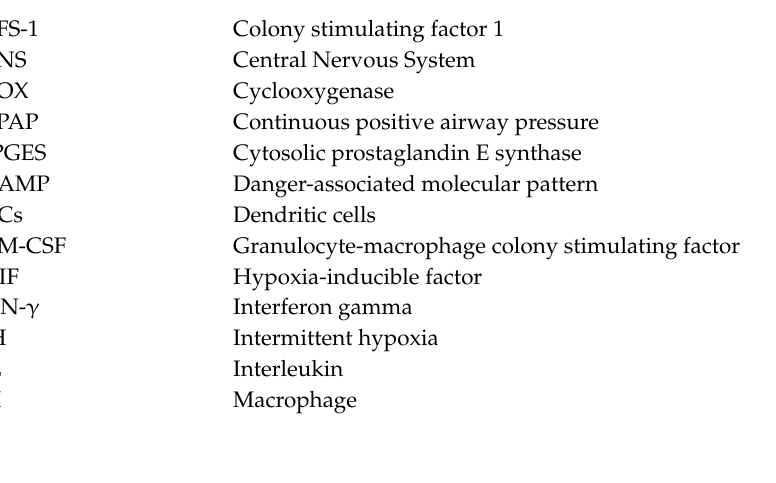
Table S1: Regulatory role of the COX-2 / Prostaglandin E2 pathway of the immunoediting mechanism in cancer